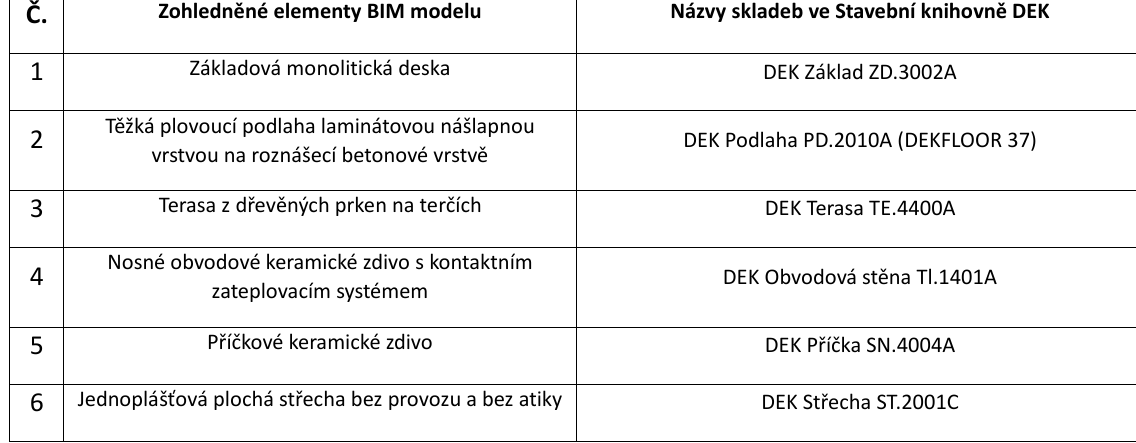
Tabulka 2: Zohledněné elementy včetně názvu skladeb ve stavební knihovně DEK (zdroj: ČERNOVICKÝ, Vojtěch. Bakalářská práce. V Praze: ČVUT, 2020, str. 61, s využitím zdroje ÚRS CZ a.s.)